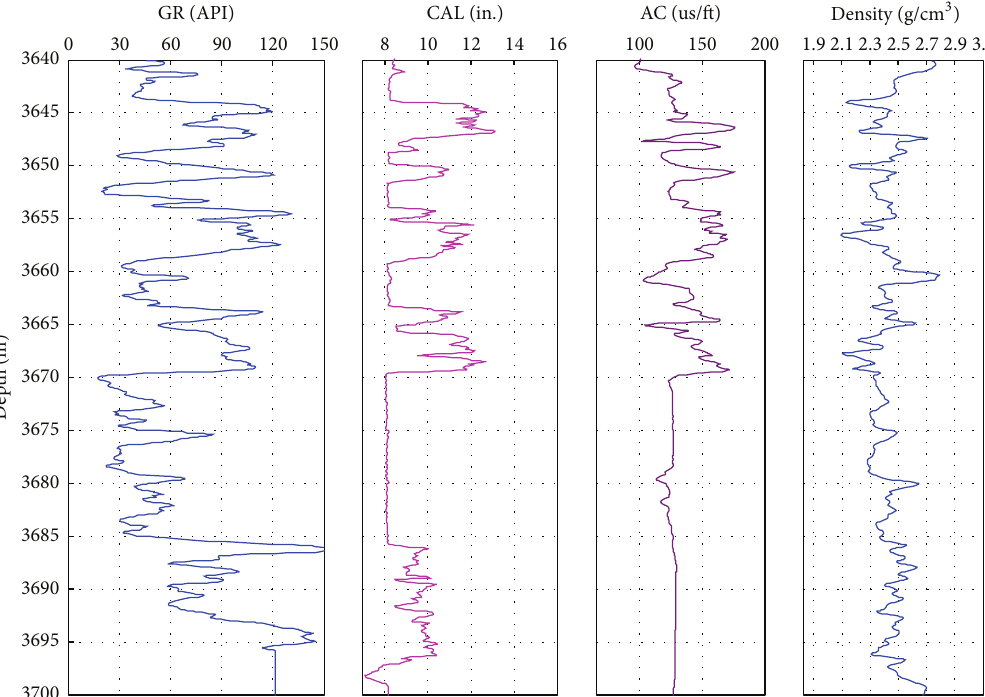
Figure 1: The comparison of the logging data in Nahr Umr Formation. GR: natural gamma logging; CAL: caliper logging; AC: acoustic transit time logging.